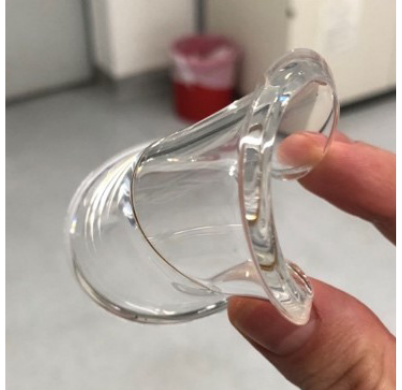
Figure 1. Cured polydimethylsiloxane (PDMS) with a ratio of 10:1 to its curing agent.